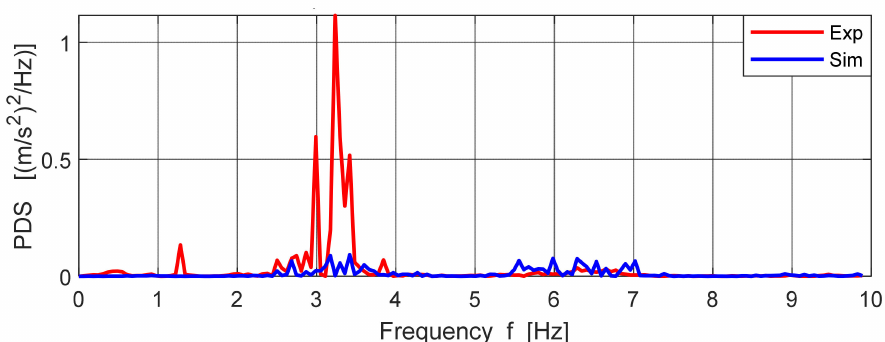
Figure 27. PSD of vertical accelerations on vehicle RA, 0–10 Hz.